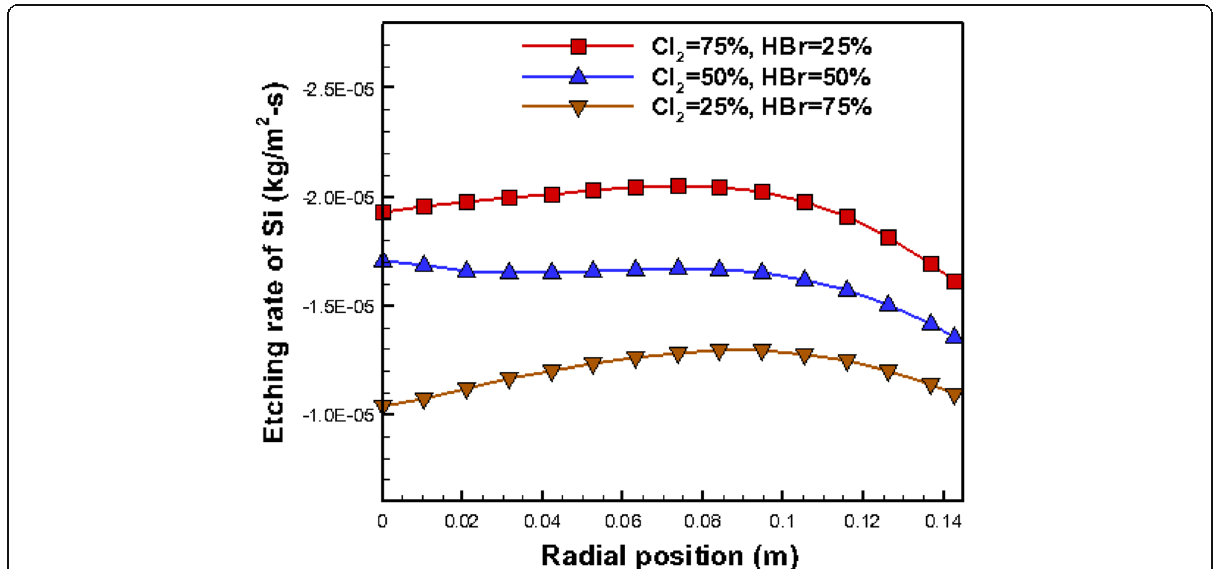
Fig. 6 Etching rates of Si on the susceptor from mixtures of inlet gases with various fractions